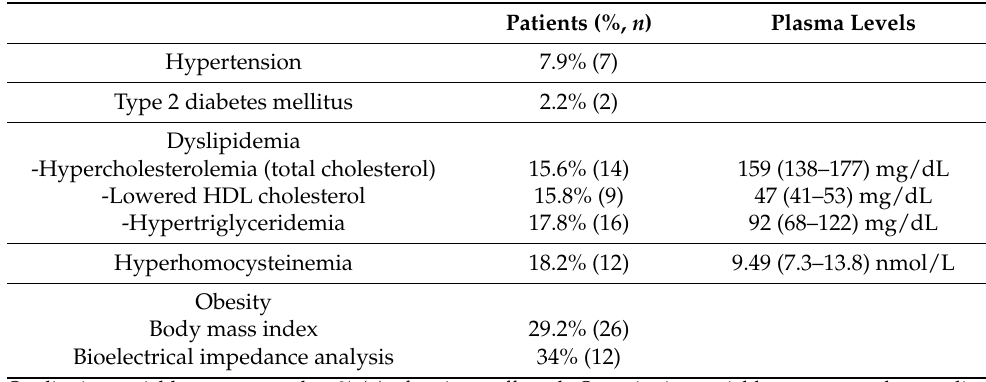
Table 2. Cardiovascular risk